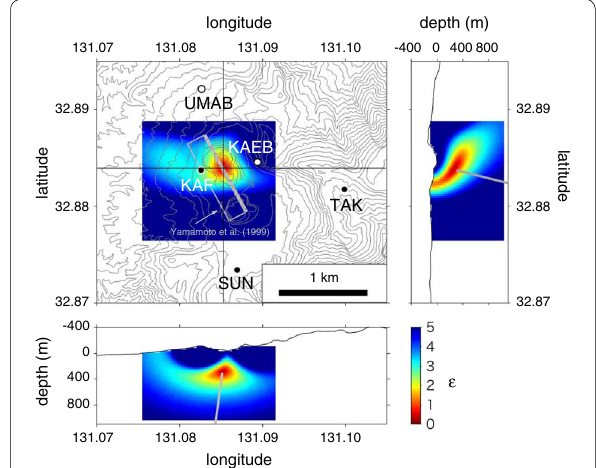
Fig. 7 Example distribution of the computed residual for source estimation. Distribution of the calculated normalized residual ǫ at 13:00 on 15 December 2013. In the map view, the estimated source location of continuous tremors is situated inside the crater, where two black lines cross. The cross sections in the NS and EW directions are along these lines. The crack-like conduit in which the source of repeated VLP events proposed by Yamamoto et al. (1999) is also shown by the gray rectangle and lines in the map and the cross sections, respectively